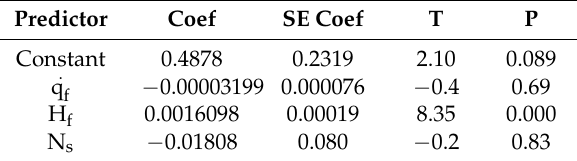
Table 11. Regression equation coefficients.